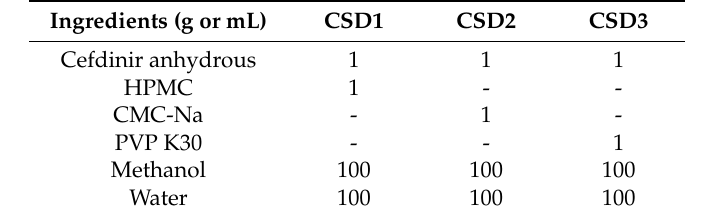
Figure 3. The water solubility of cefdinir in powder (A), CSD1 (B), CSD2 (C), and CSD3 (D), physical mixture of cefdinir and HPMC (E), physical mixture of cefdinir and CMC-Na (F), and physical mixture of cefdinir and PVP K30 (G). Data are presented as means ± standard deviation ( n = 3). * p < 0.05, compared with cefdinir in powder group. Table 1. Composition of the CSDs developed in this study.